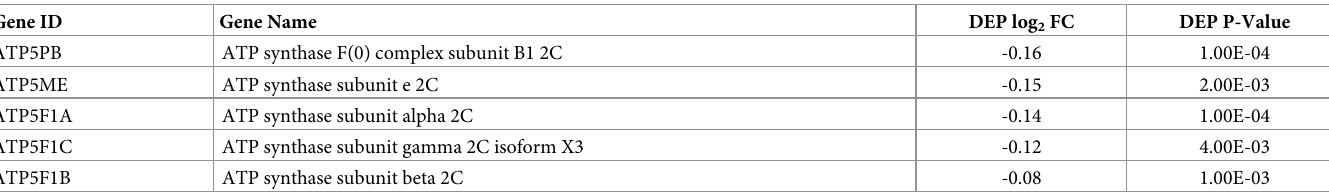
Proteins are identified by their gene ID and protein name, FC indicates fold change. An asterisk indicates the encoding gene was also differentially expressed.